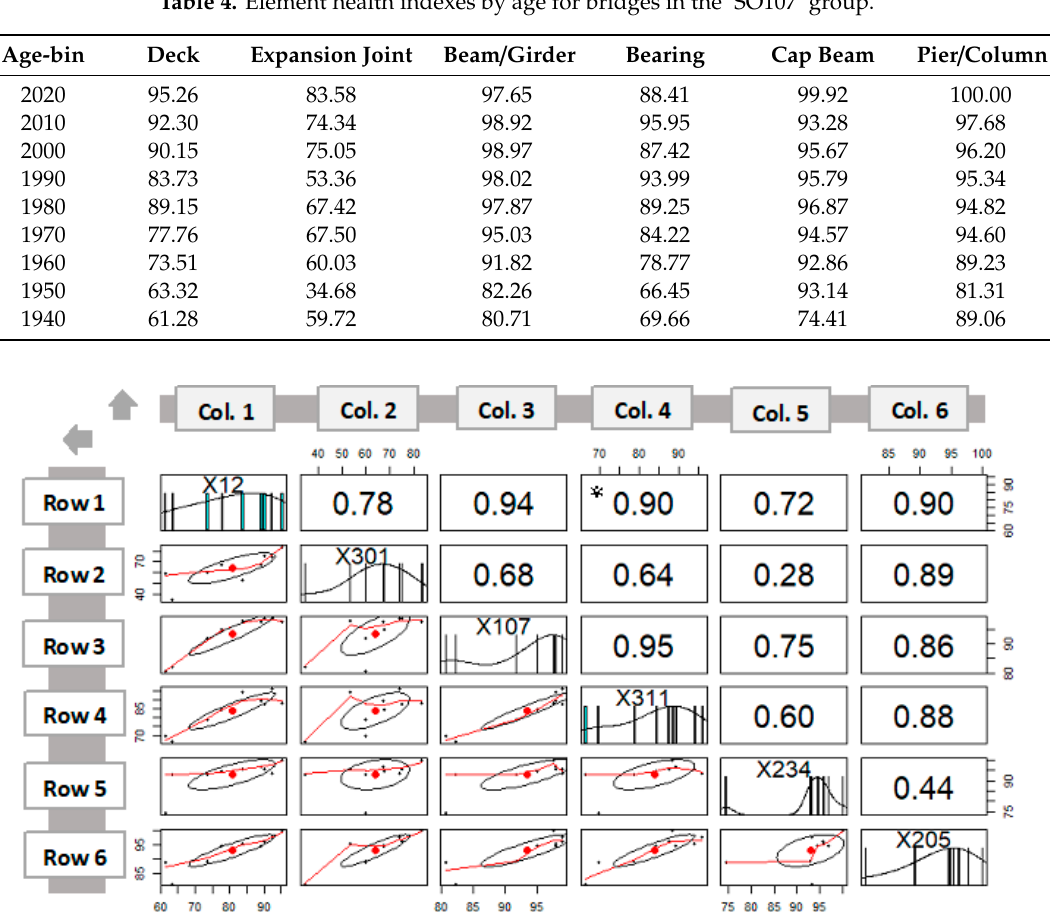
Figure 6. Contingency table for the Co-Active elements in the ‘SO107’ group. Notes: * = Co-Active coe ffi cient corresponding to “Row 1”, “Col. 4”.